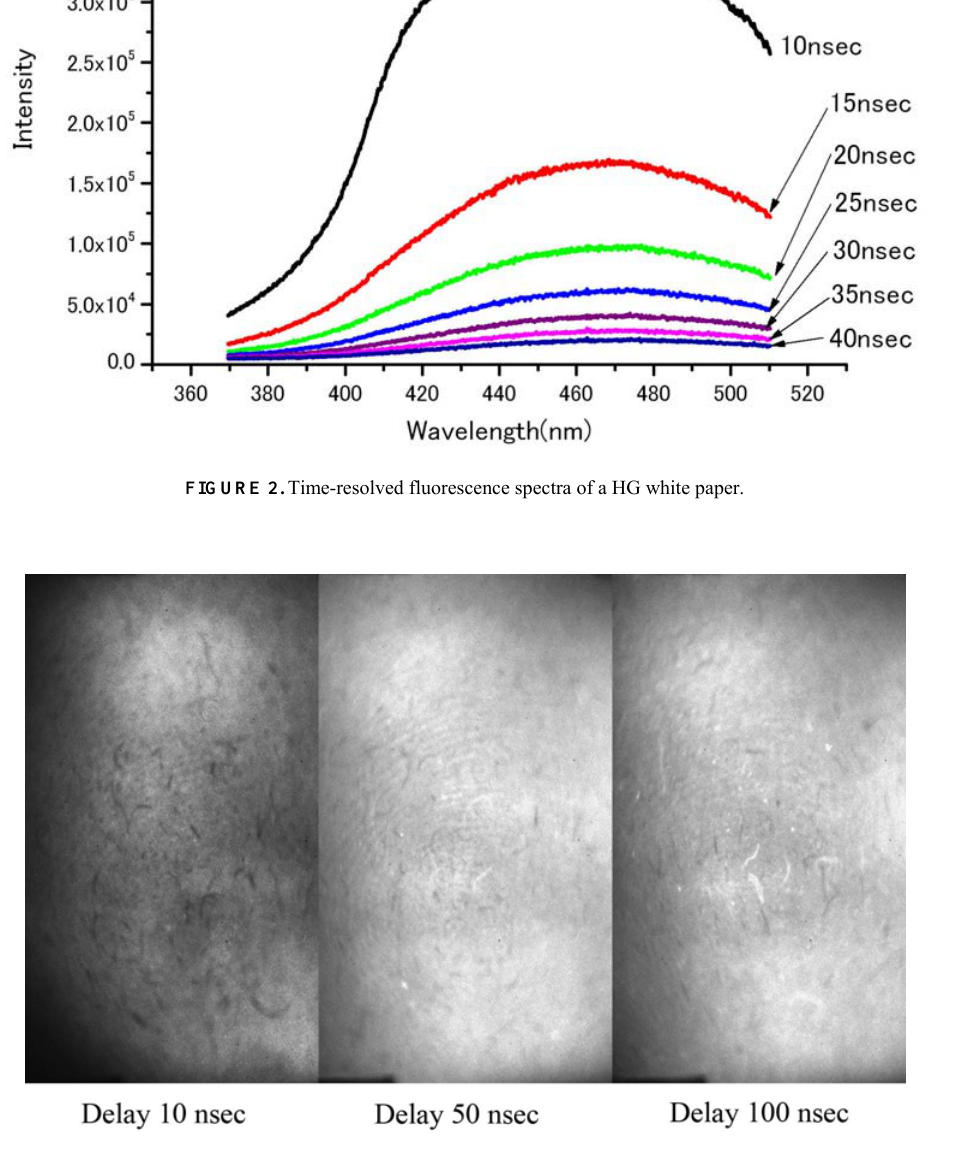
FIGURE 3. Time-resolved fluorescence images of latent fingerprints on a HG whitepaper without a filter excited with 266